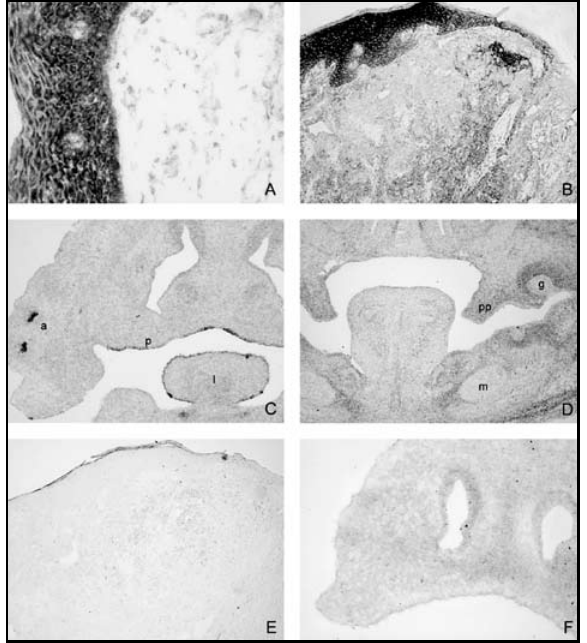
Figura 2 – Em A, observamos epitélio não-tumoral onde todas as camadas estão apresentando sinal para a sonda anti-senso PITX1. O mesmo tipo de sinal pode ser encontrado em B, sendo que o sinal para a sonda é muito menor no carcinoma epidermóide que se encontra infiltrando o tecido conjuntivo subjacente. Em embrião de camundongo de 13 dias (C e D) a sonda anti-senso SHH (C) mostra sinal no epitélio do palato (p), língua (l) e anexo cutâneo (a), em desenvolvimento. Em D,